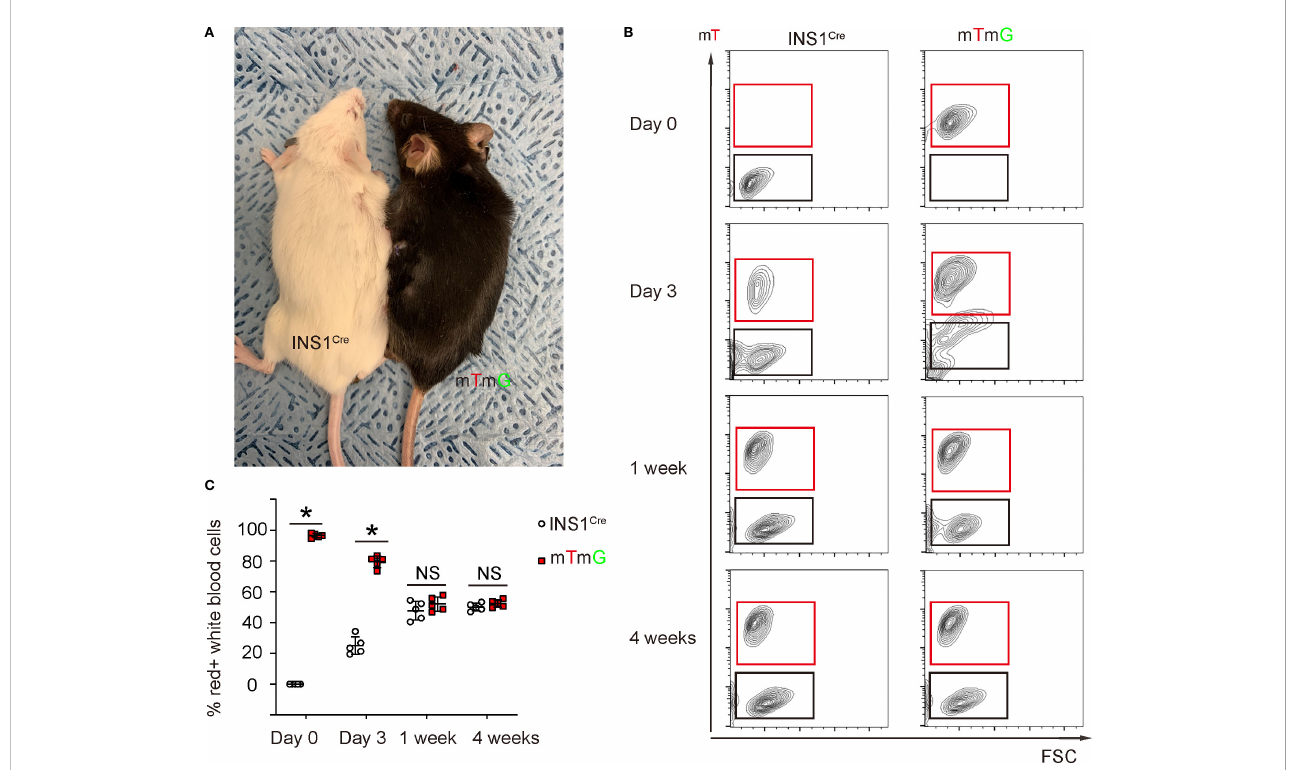
FIGURE 2 Stable blood chimerism is established as early as 7 days after parabiosis. (A) A gross image showing a ROSA-mTmG mouse and PDL-INS1 Cre knock-in mouse after parabiosis. (B, C) Blood was taken from both mice at serial time points after parabiosis to analyze the degree of chimerism. mT was analyzed by fl ow cytometry, shown by representative fl ow charts (B) and by quanti fi cation (C) . *p <0.05. NS: non-signi fi cant. N=5